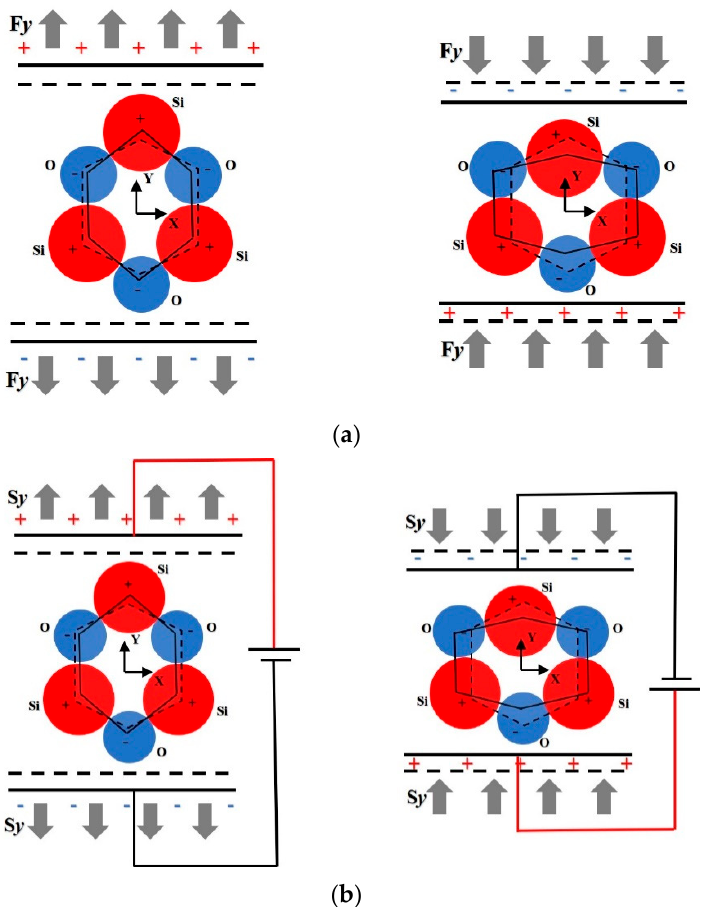
Figure 1. Schematic diagram illustrating the piezoelectric effect. ( a ) Direct piezoelectric effect, ( b ) Inverse piezoelectric effect.